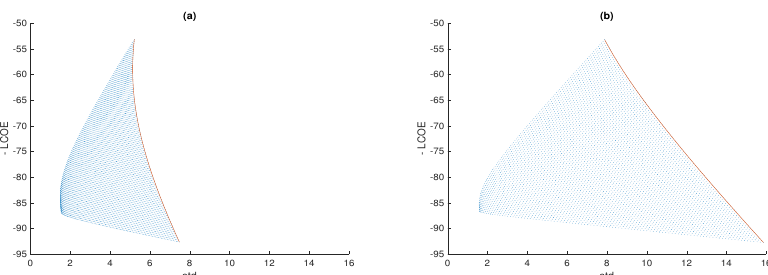
Figure 6. Power portfolio opportunity sets under the stochastic LCOE metric: ( a ) the σ ca = 0.1 case; ( b ) the σ ca = 0.2 case. In the y -axis, LCOE stands for expected LCOE. Continuous red lines depict two-asset, gas and coal, portfolio opportunity sets.